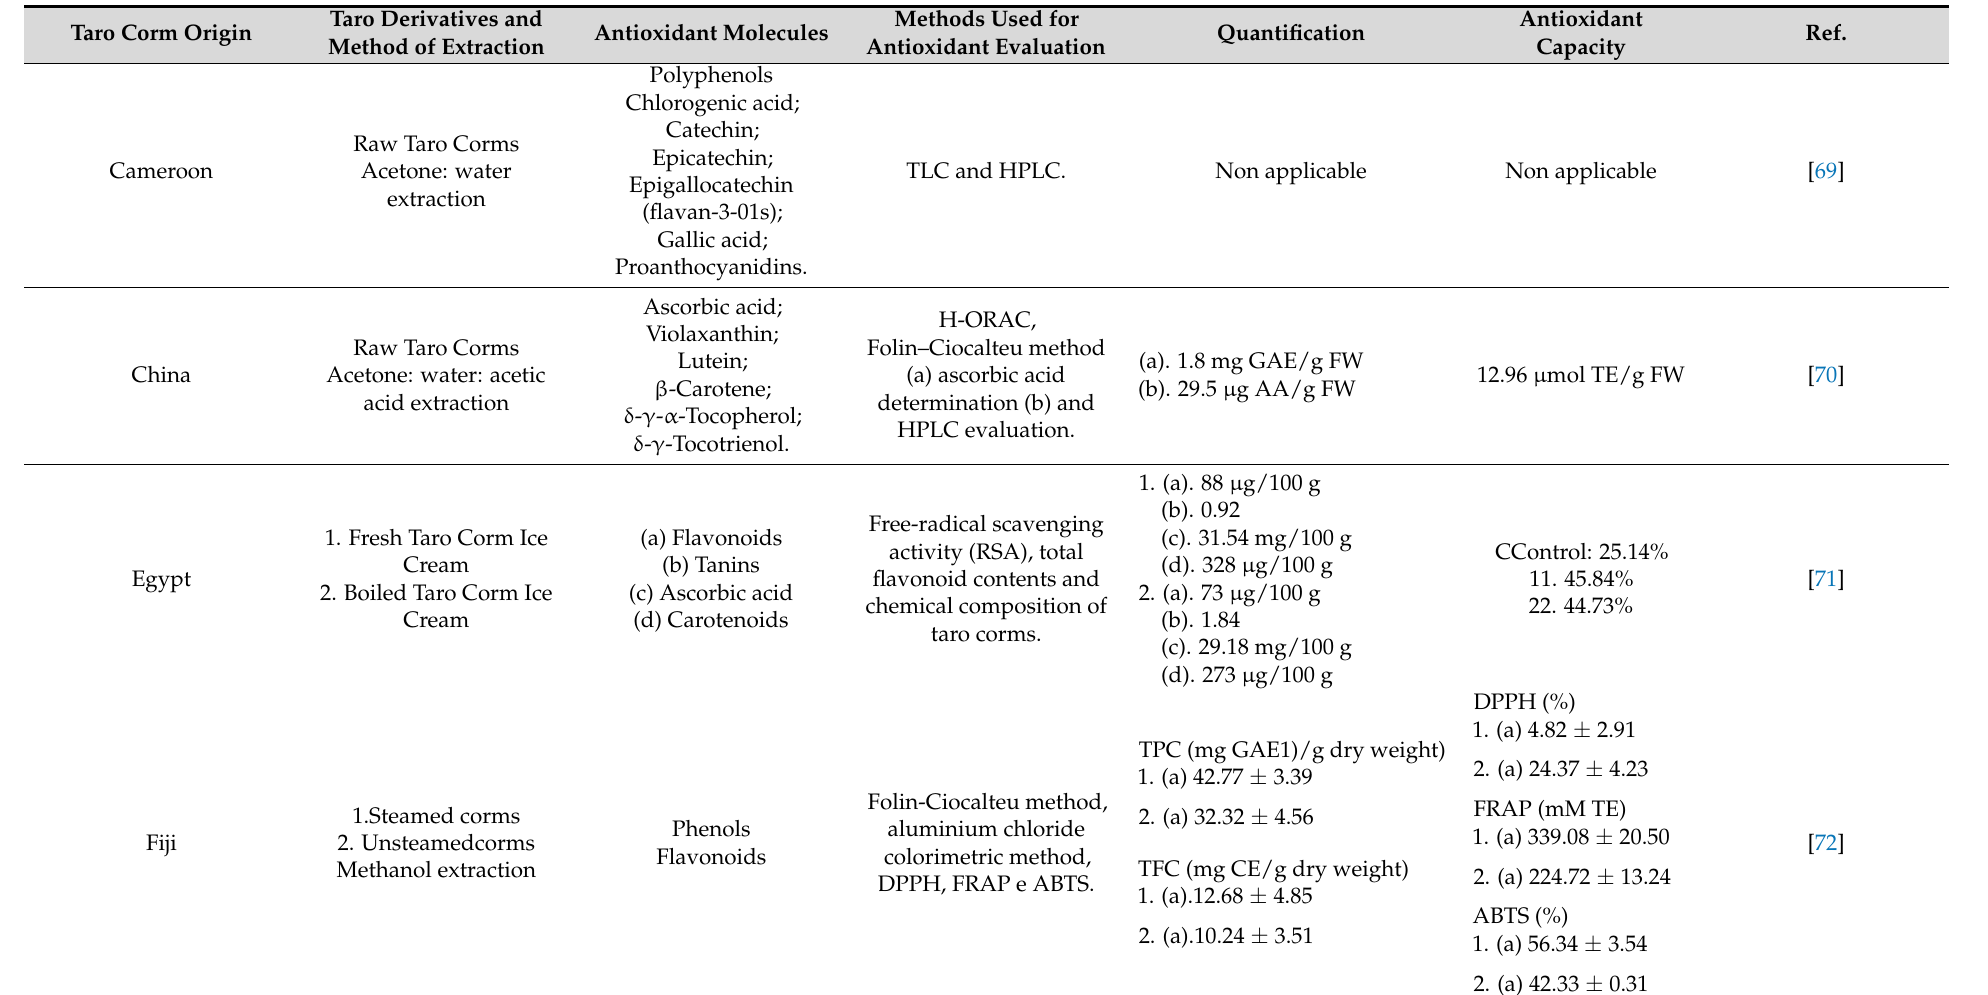
Table 3. Antioxidants in Colocasia esculenta from different geographic